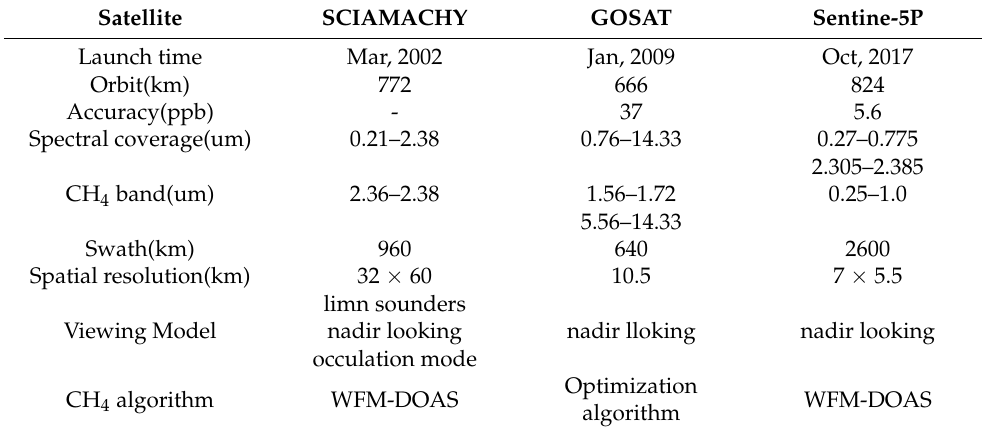
Table 2. Main parameters of three satellites.